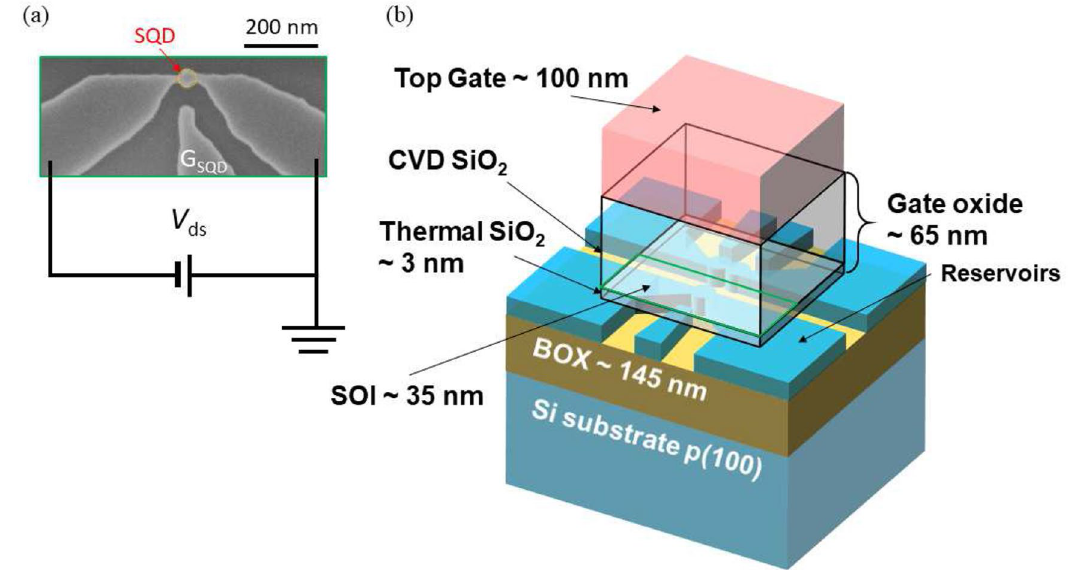
Figure 4. Device structure. ( a ) Scanning electron microscope (SEM) image of the device after reactive ion etching. Darkest areas are parts of the SOI that have been etched away whereas the island at the centre